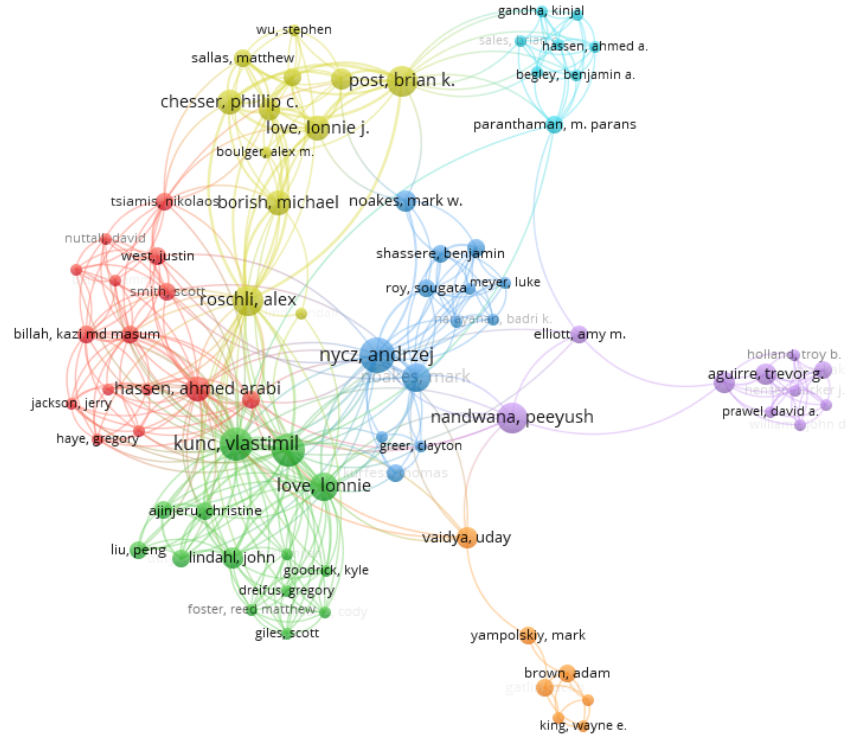
Figure 21. Mapping based on co-authorship showing the network visualization for the second method.